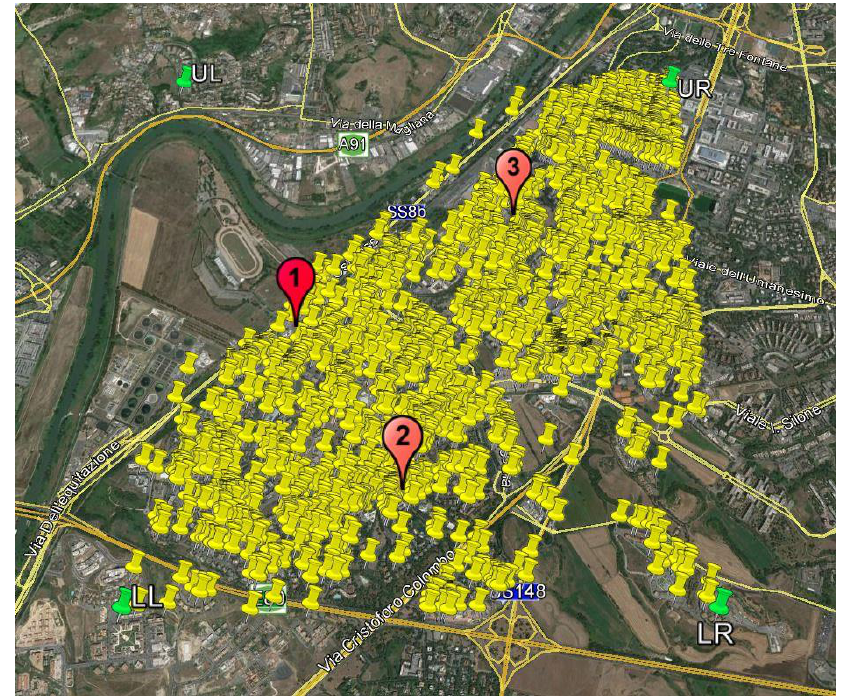
Figure 1. Representation of the 3073 stop events in the study area.